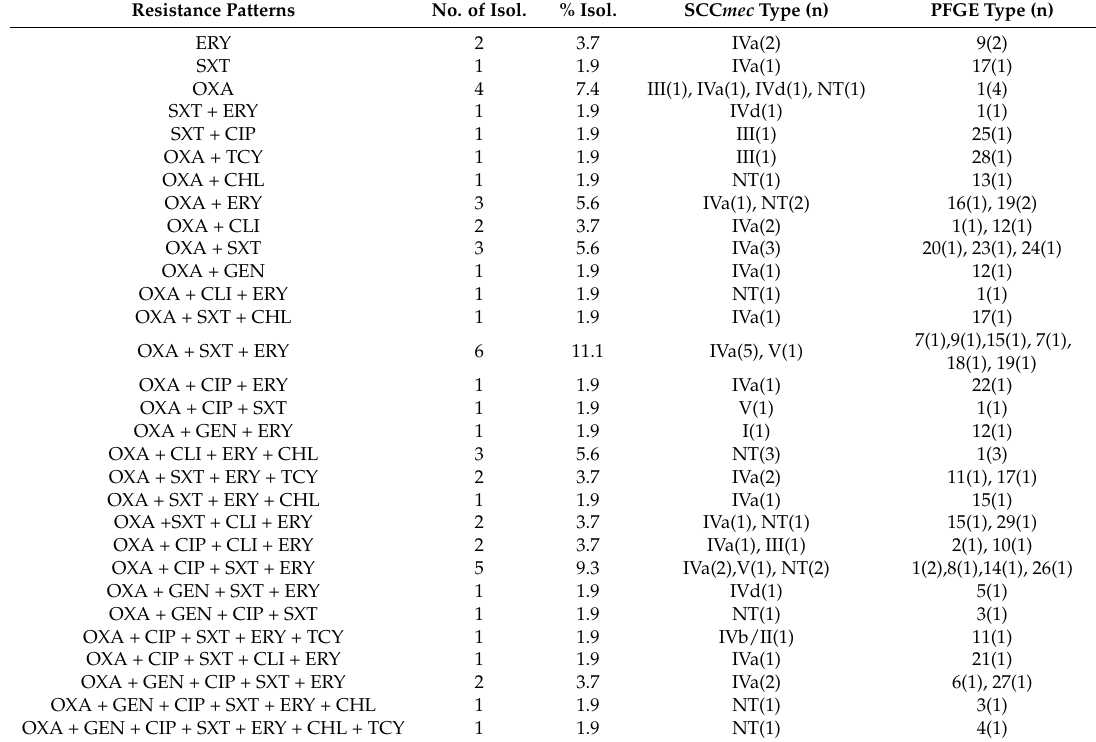
Table 3. Resistance patterns of MRSE